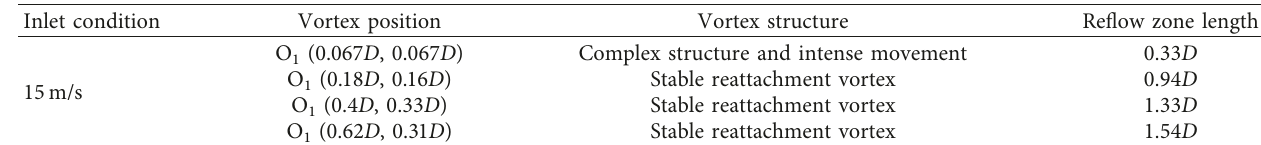
Table 4: Characteristics of sudden extension reflux zone in cross